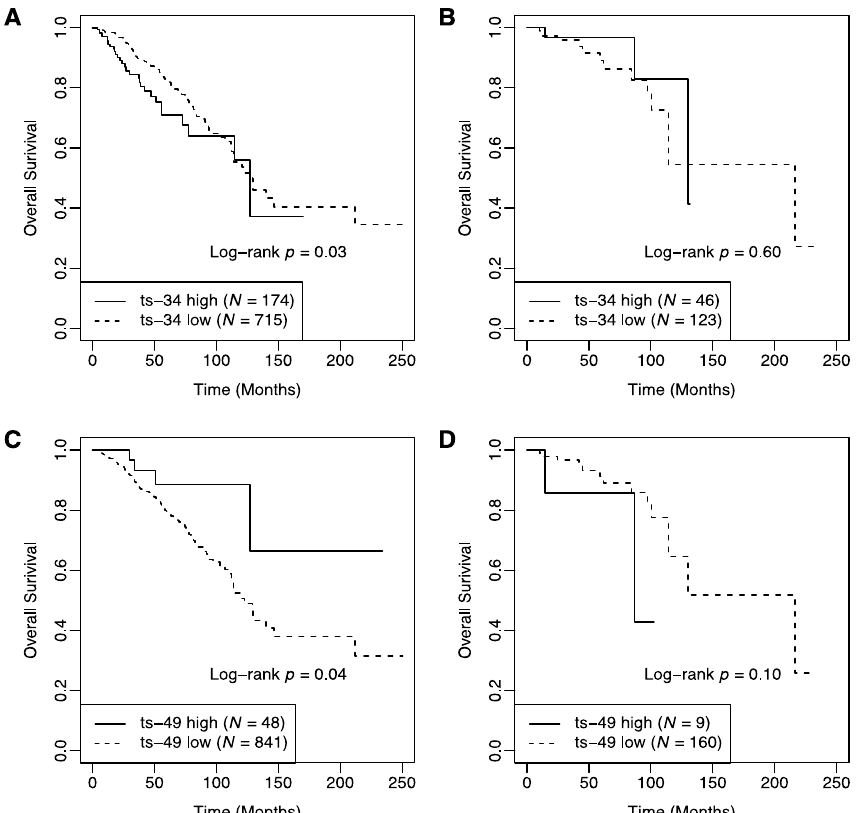
Figure 1. Kaplan–Meier survival curves of breast cancer patients stratified by T cell activation status. ( A ) In the exhaustion group, patients with a low level of ts-34 had better overall survival compared to those with a high level ( p = 0.03). ( B ) In the activation group, there was no significant difference in overall survival between patients in the high and low levels of ts-34 ( p = 0.60). ( C ) In the exhaustion group, patients with a high level of ts-49 had better overall survival compared to those with a low level ( p = 0.04). ( D ) In the activation group, there was no significant difference in overall survival between patients in the high and low levels of ts-49 ( p = 0.10).